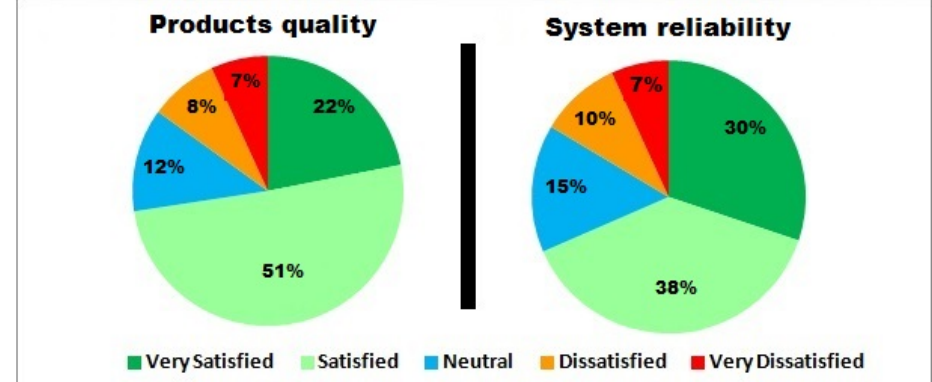
Figure 14. Users’ expectations and their ability to make the right decisions.